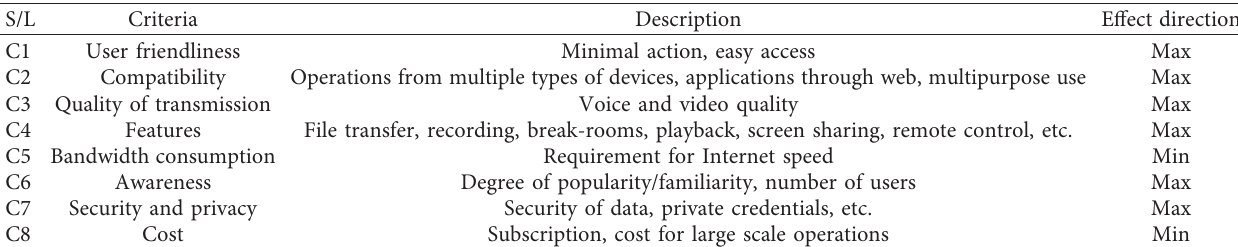
Table 1: List of criteria considered to compare VC